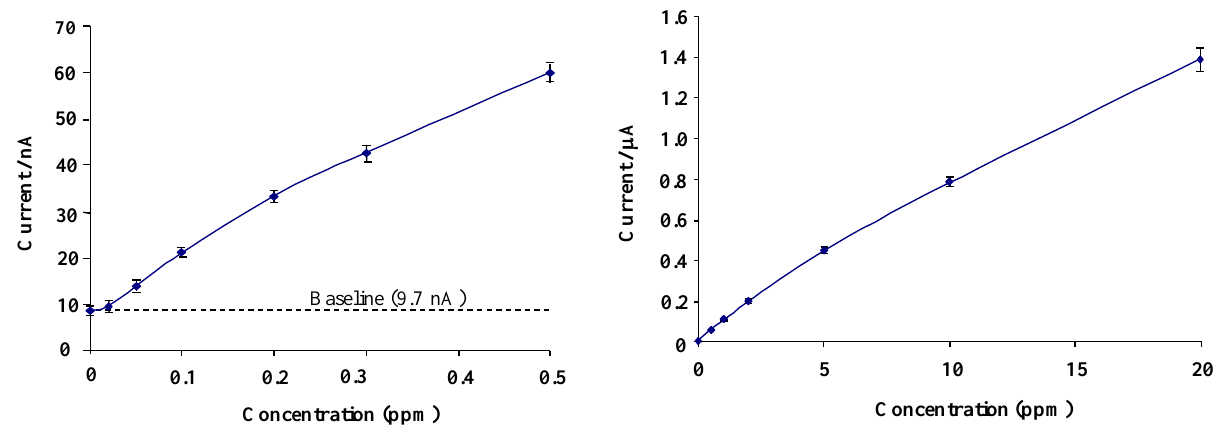
Figure 10. Free chlorine calibration curve; ―Low‖ range 0 to 0.5 ppm (Mean RSD 3.8%), ―High‖ range free chlorine calibration curve from 0 to 20 ppm (Mean RSD